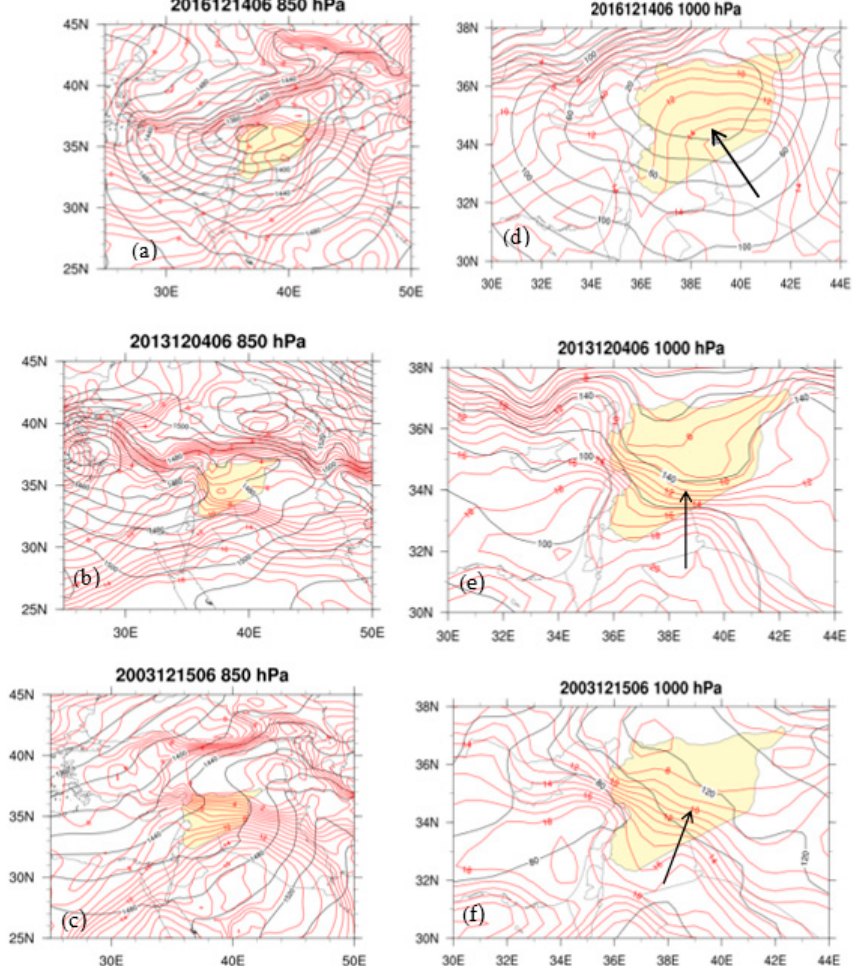
Figure 5. Circulations during strong precipitation days at 850 hPa (( a ) 20161214, ( b ) 20131204, ( c ) 20031215) and 1000 hPa ( d ) 20161214, ( e ) 20131204, ( f ) 20031215). The black arrows indicate the direction of the warm front movement. The red line indicates the contour of temperature (unit: °C) and the black line indicates the contour of geopotential height (unit gpm). The black vectors in Figure 5d–f indicate the direction of the dry, warm front movement.